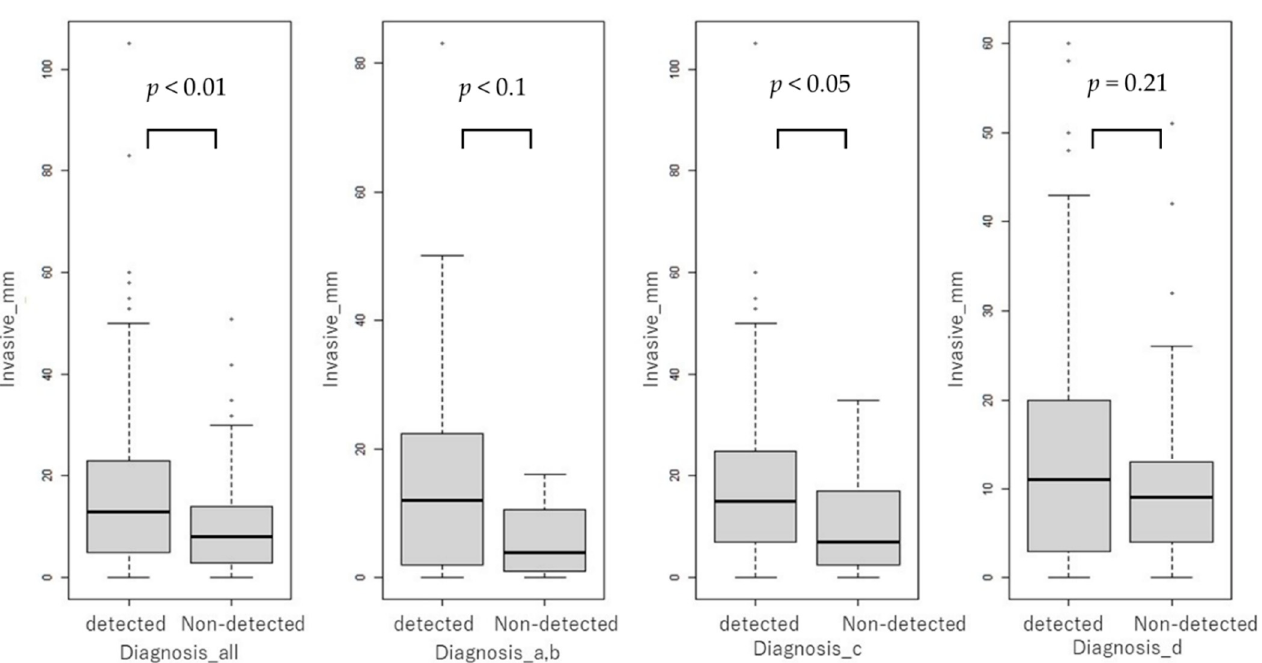
Figure 3. Size of invasion in the non-detected and detected groups, as shown by mammography.